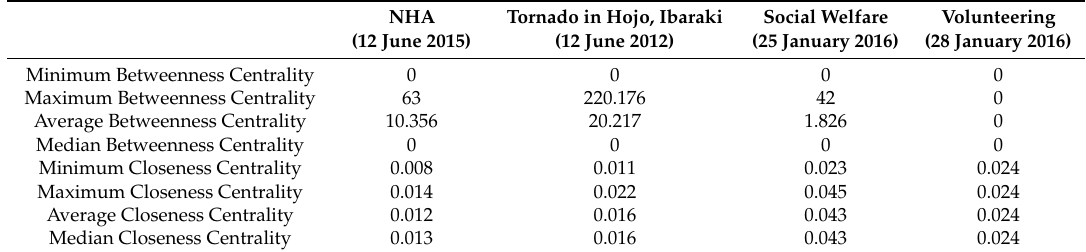
Table B1. Min., Max., Avg. and Median Betweenness Centrality and Closeness